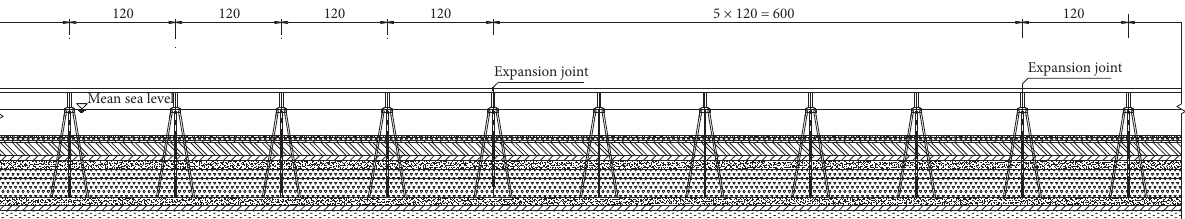
Figure 2: Configuration of the (5 × 120)m continuous bridge (unit: m).